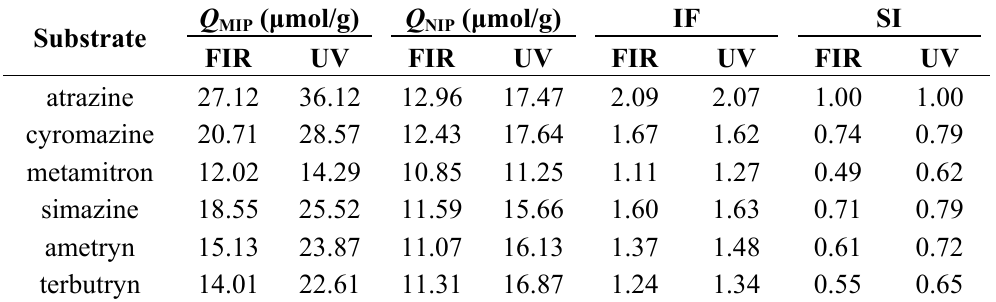
), imprinting factors (IF) and standardized max , MIP , NIP and NIP ( n = FIR UV FIR UV